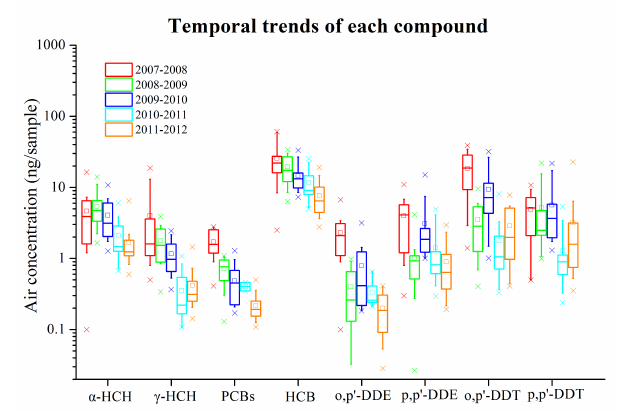
Figure 7. The temporal trends of each compound over the 5 sam- pling